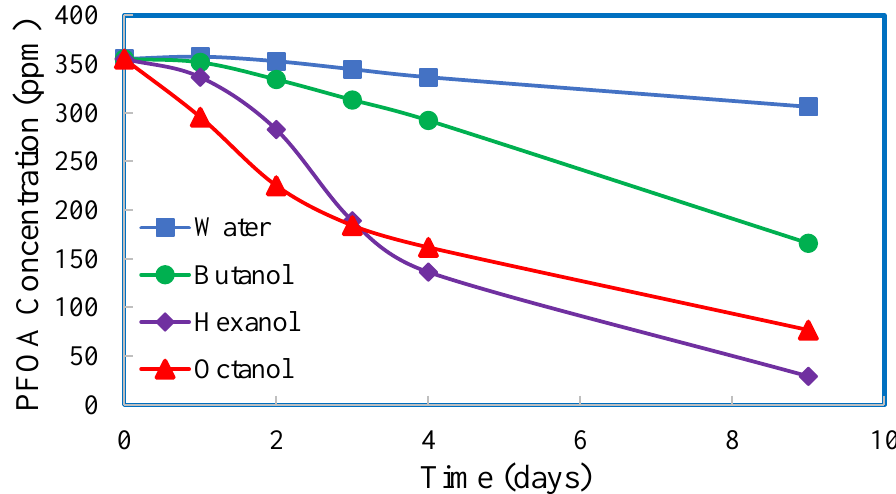
Figure 10. PFOA concentrations in deionized water. Initial PFOA concentration in deionized water on the left-hand side of the membrane test system = 350 mg/L. The right-hand side of the membrane test system contained alcohol. All membranes were PDMS without imbedded particles.